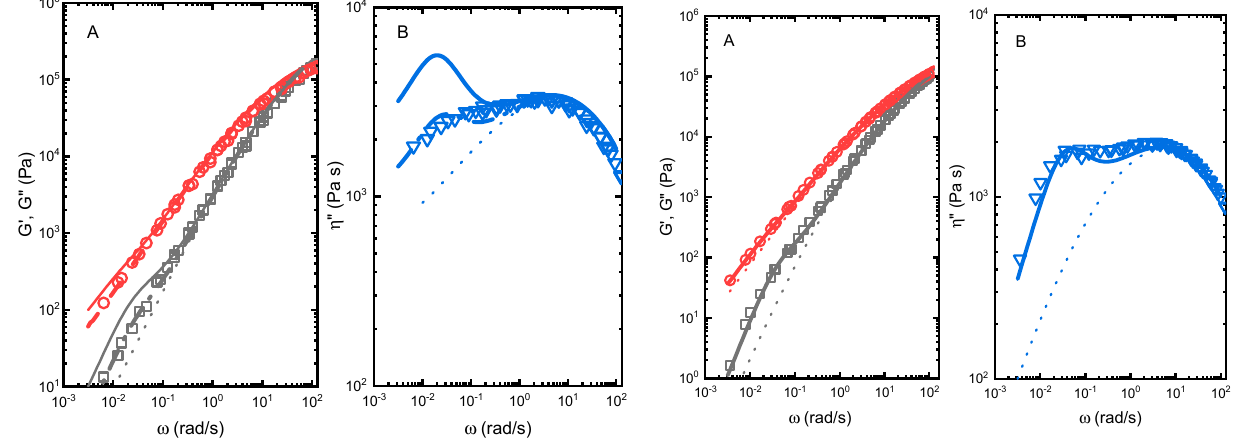
Figure 7. ( A ) Storage ( □ ) and loss ( Ο ) moduli and ( B ) out-of-phase component of complex viscosity ( σ ) versus angular frequency for PE0.0/EVA 80/20 blend ( left ) and PE_ZN/EVA 80/20 ( right ) at T = 150 °C. The dotted curves are the calculations for a miscible blend. The solid lines represent the results of the Palierne model for immiscible blends with α /R = 0.8 kN·m − 2 . The dashed lines represent the behaviour obtained for a partially miscible blend with X = 0.6 and α /R = 0.8 kN·m − 2.